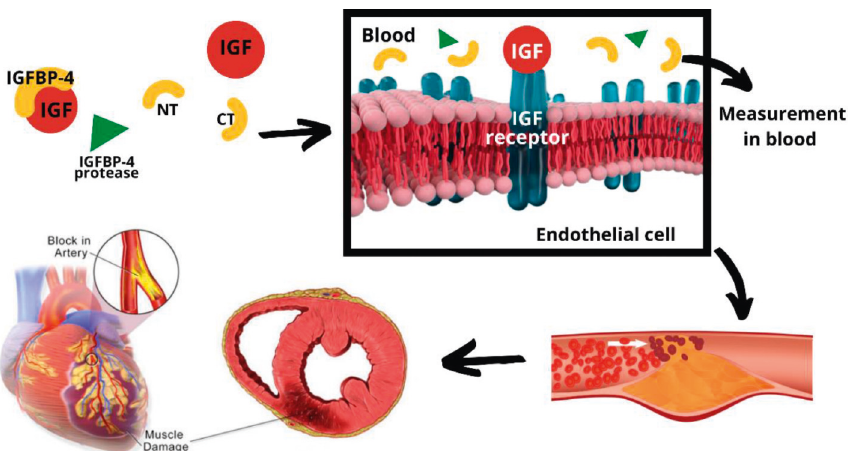
Figure 1: Cleavage of IGFBP-4 liberates free IGF which causes endothelial proliferation, promotes atherosclerosis, and ischemia eventually leading to myocardial infarction.